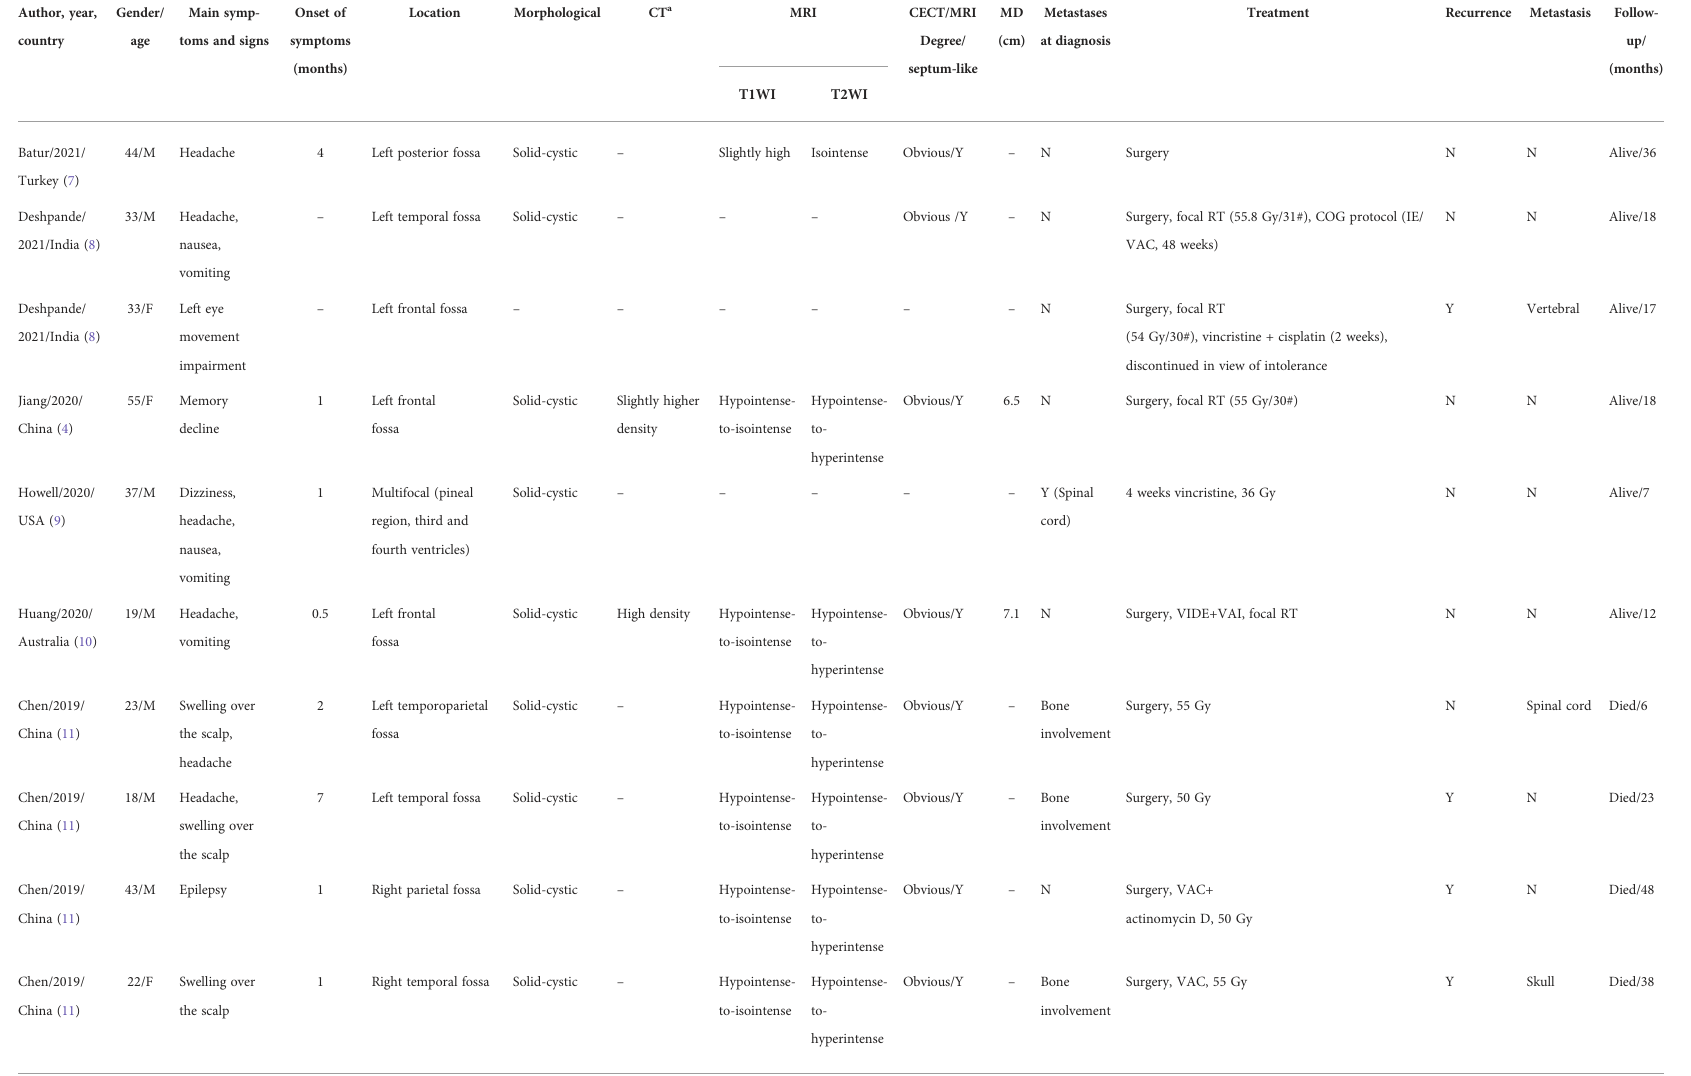
TABLE 1 Clinical and imaging features of the cases of primary intracranial EWs/PNETs.